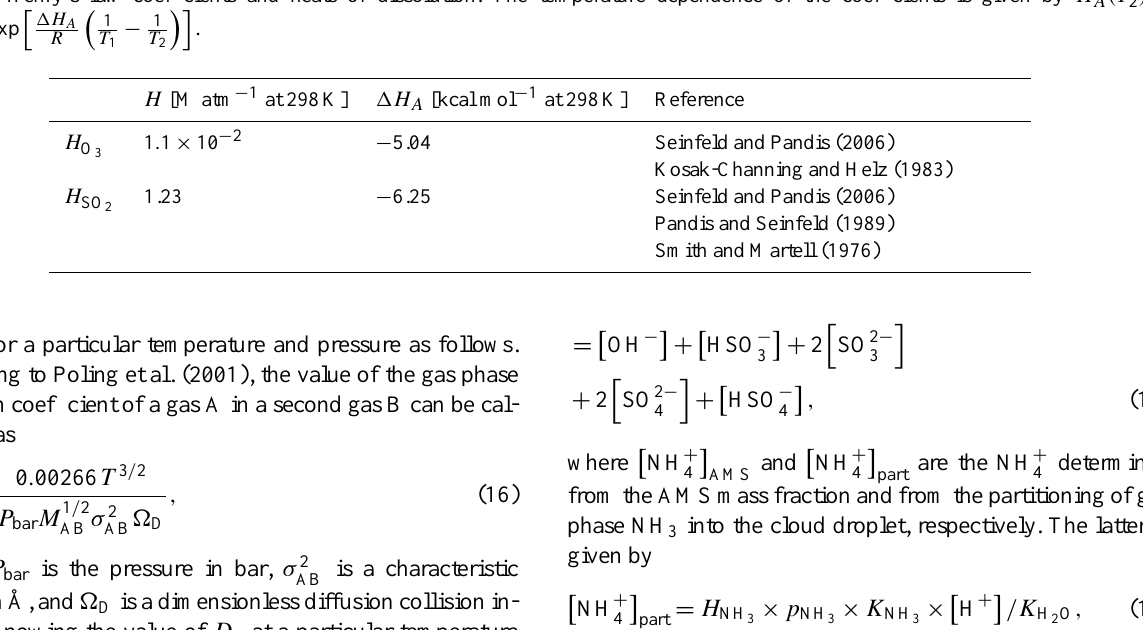
Table 2. Henry’s law coefficients and heats of dissolution. The temperature dependence of the coefficients is given by H A (T 2 )